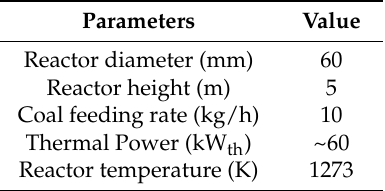
Table 1. Main operating parameters used in simulations.